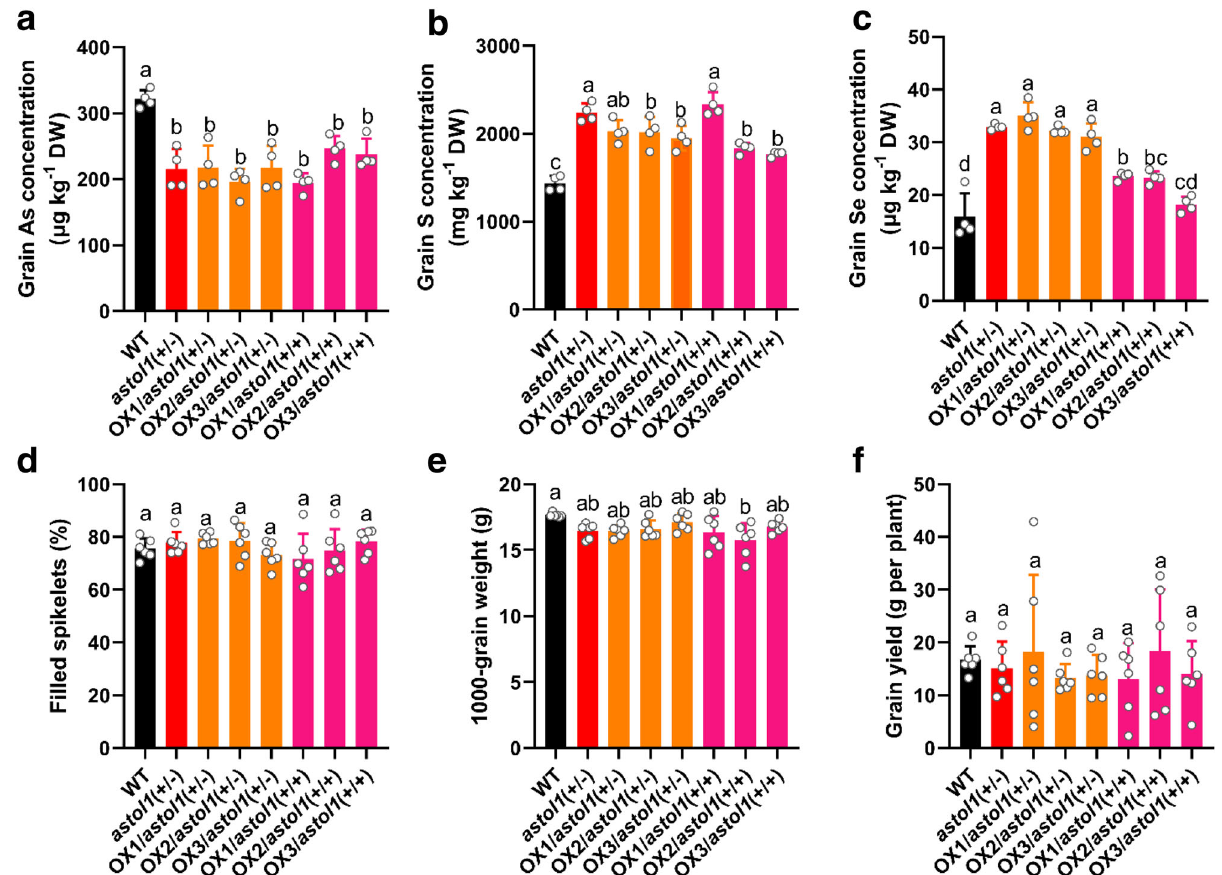
Fig. 5 Mutation allele of OsASTOL1 reduces As and increases S and Se concentrations in rice grain. Grain As ( a ), S ( b ), and Se ( c ) concentrations of WT, astol1 ( + / − ), and three independent OsASTOL1 overexpression lines in the astol1 ( + / − ) or astol1 ( + / + ) background. Plants were grown in a paddy fi eld of Nanjing (12.5 mg kg − 1 As and 0.61 mg kg − 1 Se in the soil). d – f Yield components of WT, astol1 ( + / − ), and three overexpression lines in astol1 ( + / − ) or astol1 ( + / + ) background. After harvest, fi lled spikelets ( d ), 1000-grain weight ( e ), and grain yield ( f ) were recorded. DW, dry weight. WT, wild type. astol1 ( + / − ), astol1 heterozygote. astol1 ( + / + ), astol1 homozygote. Data in a – f are shown as means ± s.d., n = 4 ( a – c ) or 6 ( d – f ) biological replicates; each biological replicate represents an individual plant. Different letters in a – f indicate signi fi cant differences ( P < 0.05) using one-way ANOVA followed by Tukey ’ s